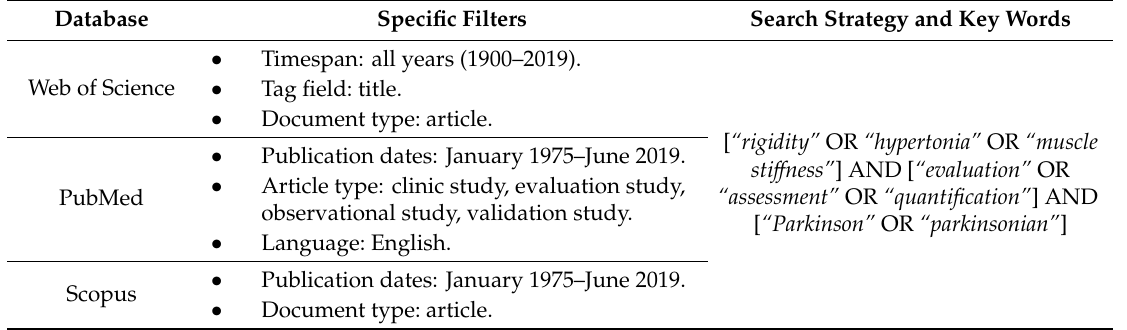
Table 1. Detailed search